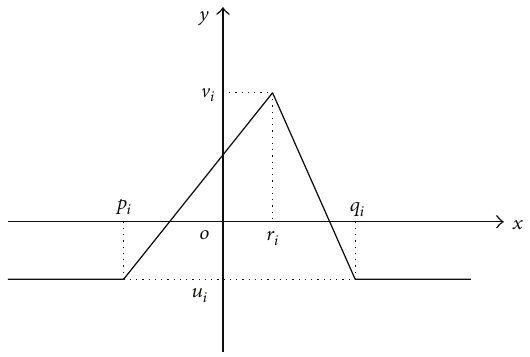
Figure 1: Mexican-hat-type activation functions